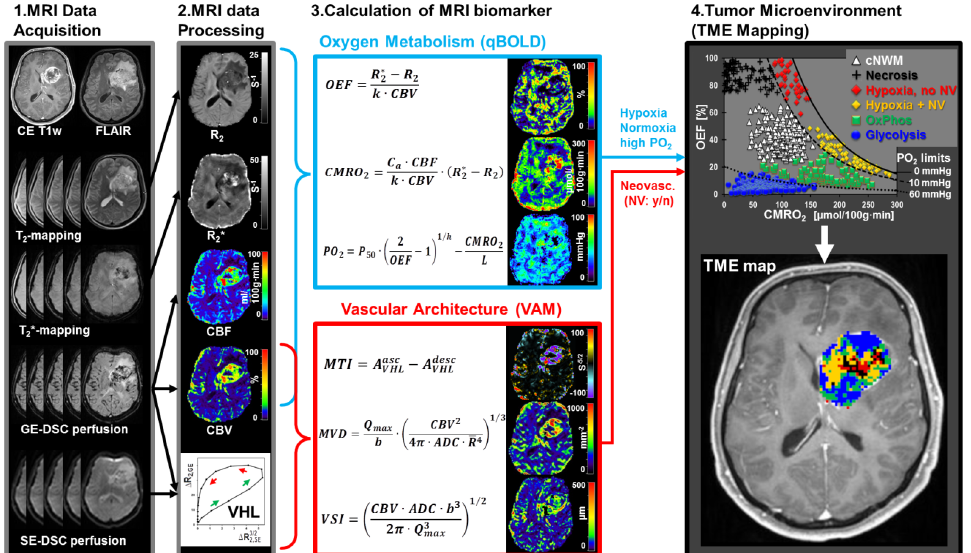
Figure 3. Work flow of the TME mapping method. Note: The TME map has the same color code as depicted in the OEF-CMRO 2 -scatterplot. The solid black line in this scatter plot indicates the isoline for PO 2 = 0 mmHg, the dashed isoline for PO 2 = 10 mmHg, and the dotted isoline for PO 2 = 60 mmHg, respectively. These lines border the areas with hypoxia (PO 2 between 0 and 10 mmHg), normoxia (PO 2 between 10 and 60 mmHg), and high tissue oxygen tension (PO 2 > 60 mmHg).